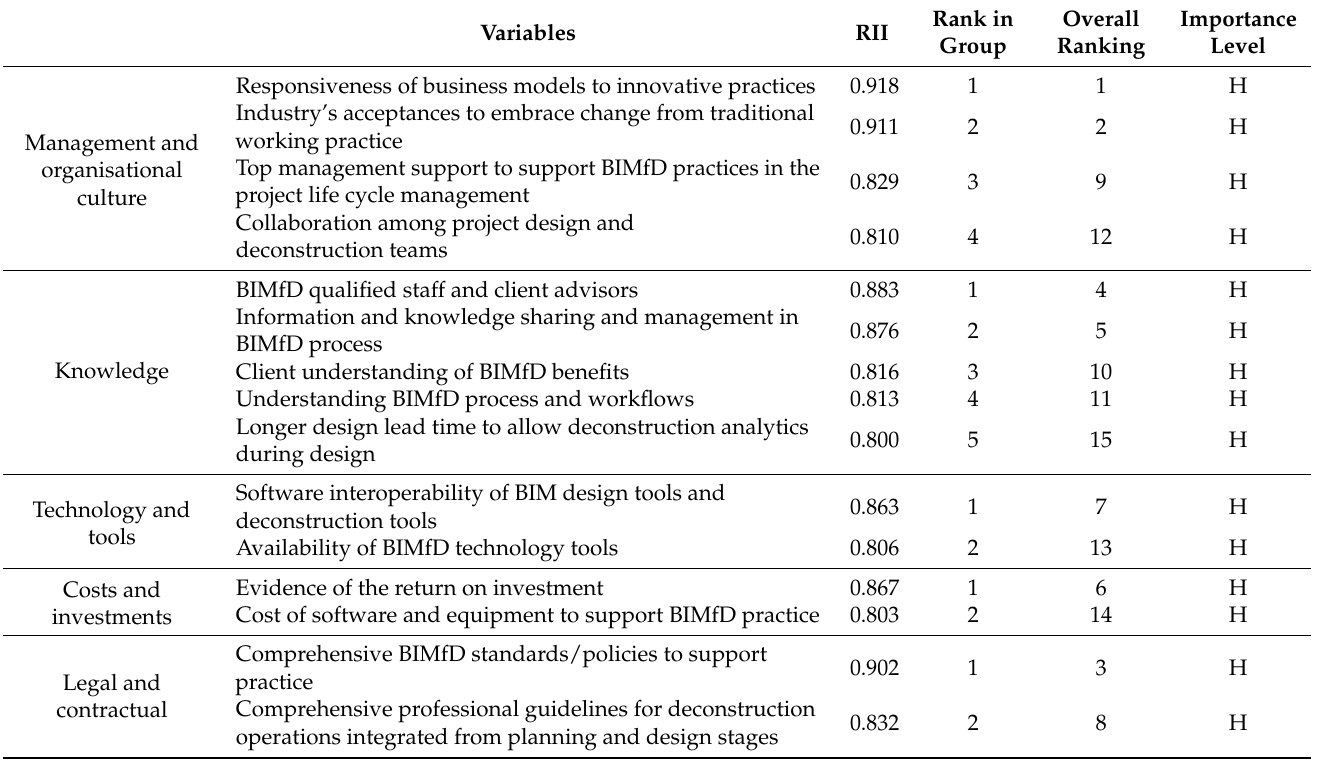
Table 5. BIMfD implementation